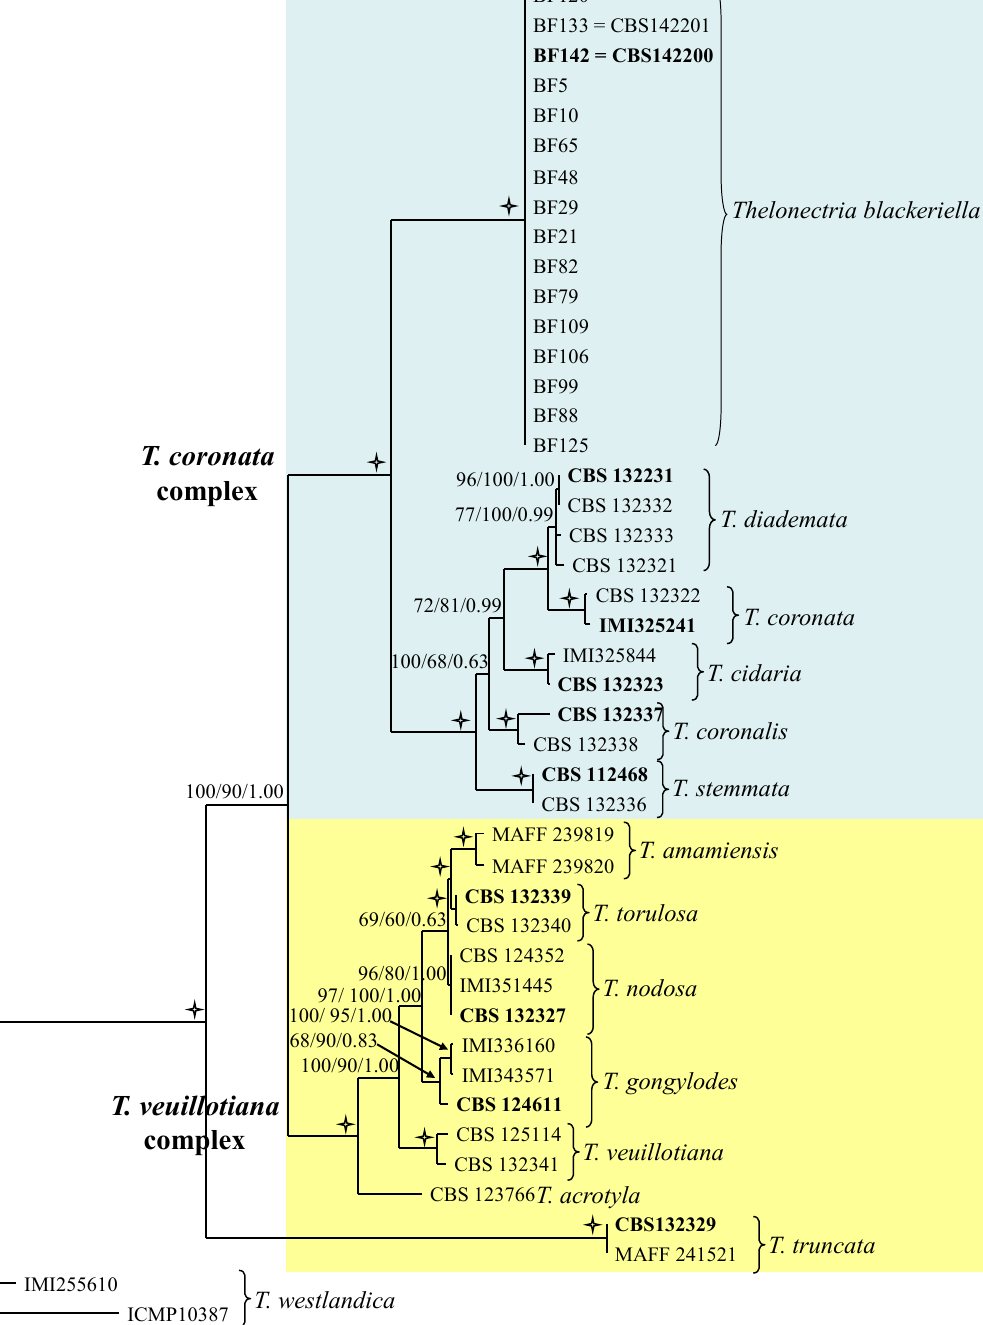
Figure 5. One of the two most parsimonious trees obtained from multiple alignment of the five genes (LSU, ITS, β -tub, act, rpb1) with bootstrap values from 1,000 replicates from maximum likelihood/maximum parsimony/Bayesian posterior probability shown at the internodes. Bootstrap values of 100% are indicated with star symbols. Ex-type sequences are highlighted in bold. Thelonectria westlandica was included as